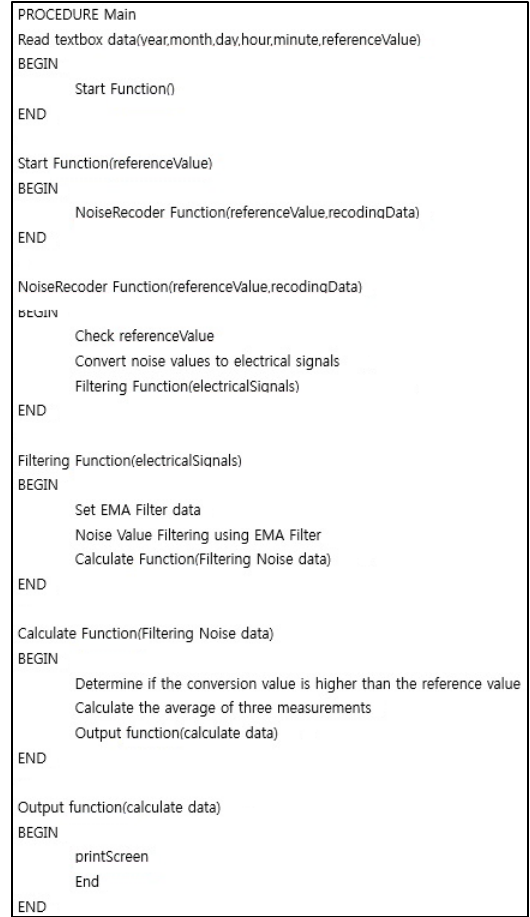
Figure 8. Unified modeling language (UML) implemented with Java Android.